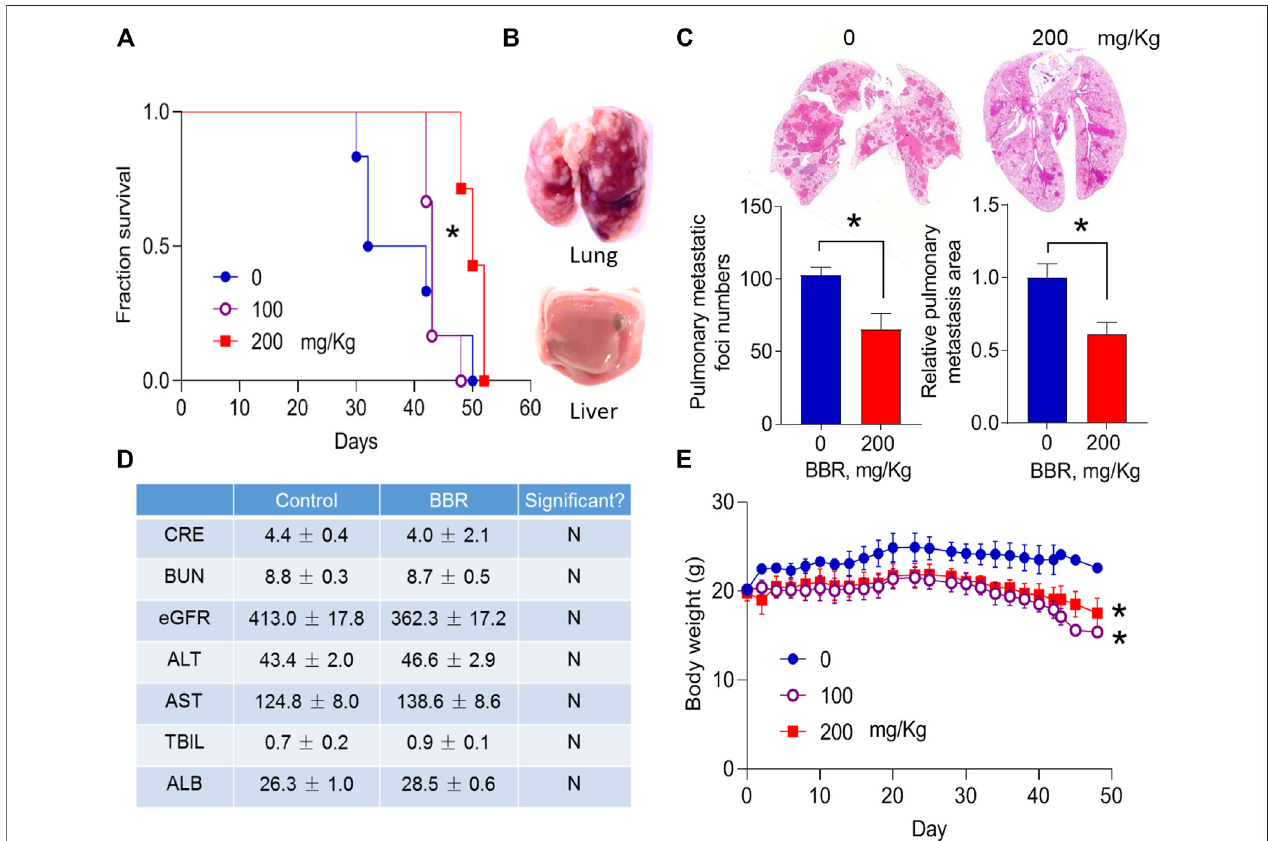
FIGURE 1 | BBR inhibits lung metastasis of pancreatic cancer cells (A) . Effect of BBR on the survival of mice that were intravenously injected with PC cells (B) . Morphological changes of the resected lungs and livers from dead mice (C) . Effects of BBR (BBR, 200 mg/kg, oral gavage daily) on the number and total area of lung metastatic foci (D) . Effect of BBR on the biochemical metabolism of mice (E) . Body weight changes of mice during drug treatment. * p < 0.05; n = 6 in (A) , Log-rank (Mantel-Cox) test; n = 6 in (C) , n = 5 in (D) , Student ’ s t- test; n = 7 in (E) , two-way analysis of variance (ANOVA) with Dunnett ’ s multiple comparison test.